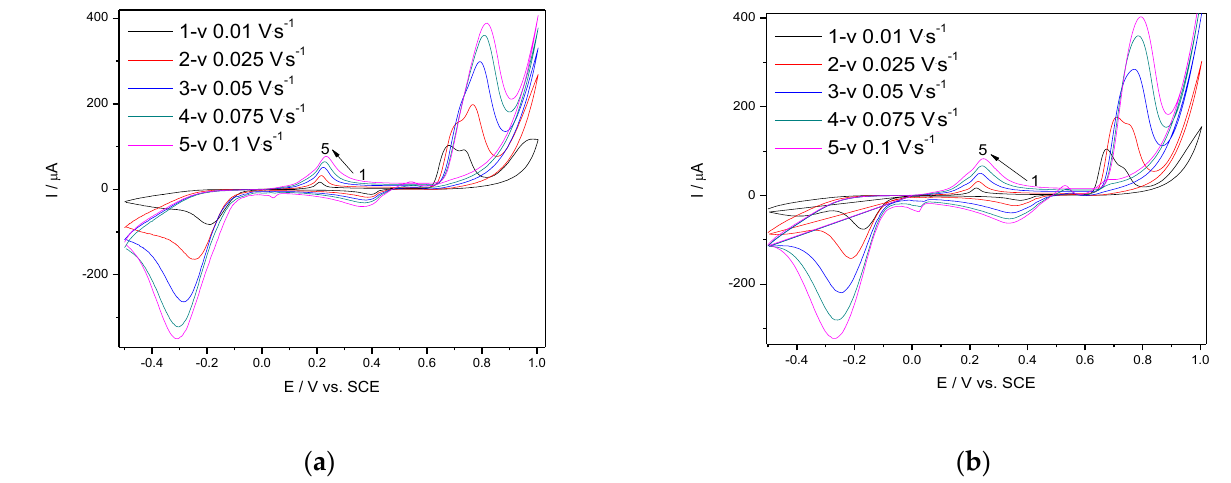
Figure 3. CVs recorded at Ag/GO/BDD electrode with various scan rates ranged from 0.010 to 0.100 V·s − 1 in: 0.1 M NaOH supporting electrolyte ( a ) and 40 µM TC ( b ).